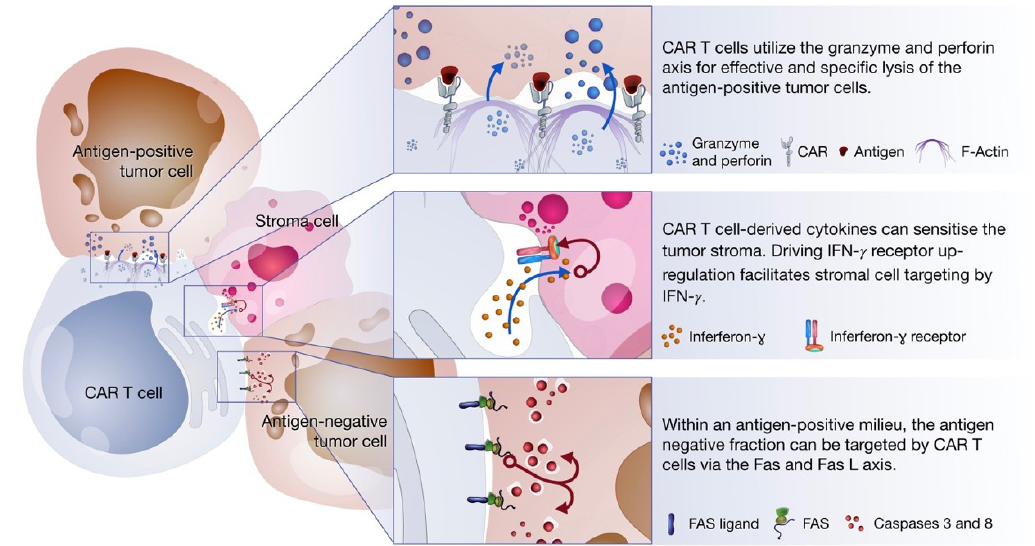
Figure 3. CAR T cells mediate tumor killing via three axes: (1) Perforin and granzyme axis: Targeting antigen positive fraction. (2) Cytokine secretion: Stromal cell sensitization. (3) Fas and FasL axis: Targeting antigen-negative fraction.